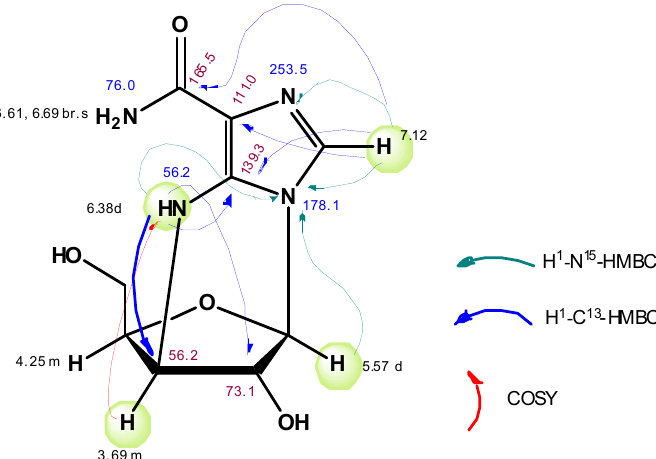
Figure 2. The structural formula of nucleoside 10 .